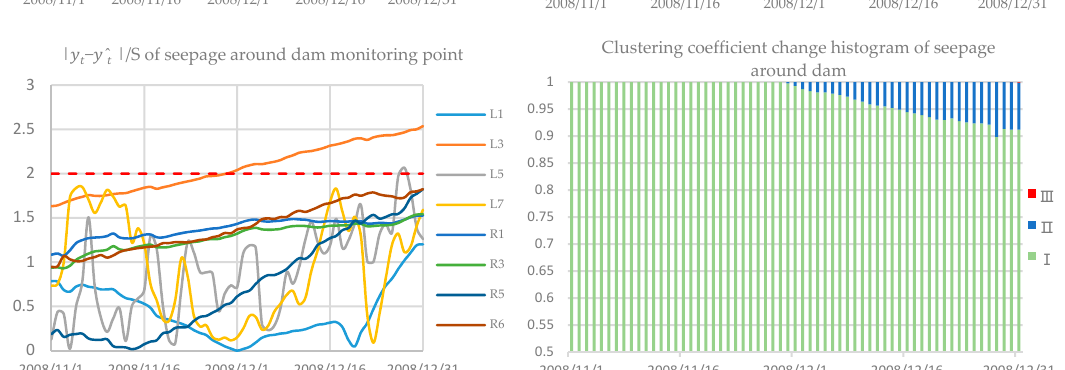
(cid:12) (cid:12) (cid:12) (cid:12) (cid:12) y t − ˆ y t (cid:12) / S and the clustering coe ffi cient of each seepage indicator.